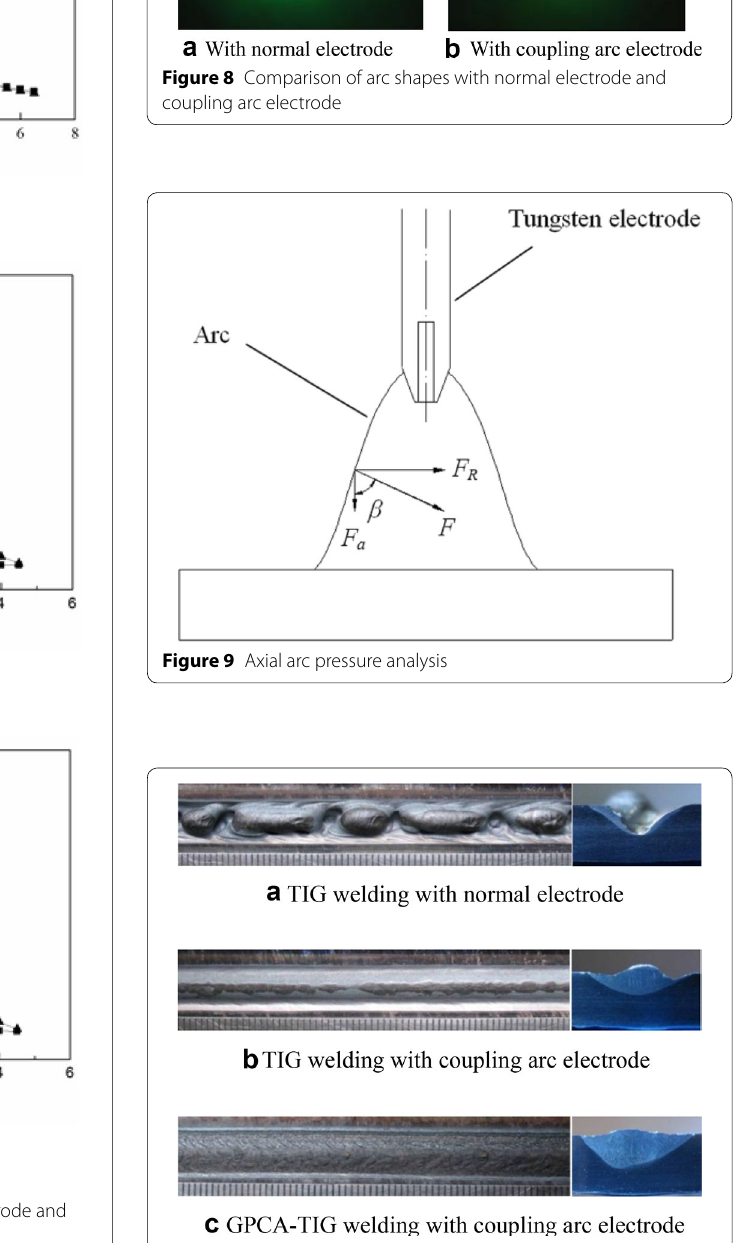
Figure 10 Comparison of weld